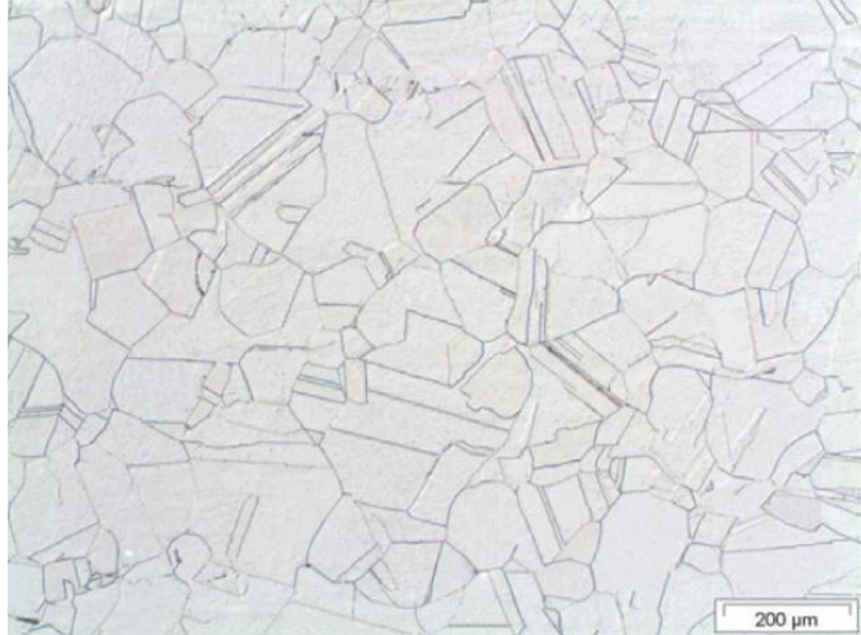
Figure 1. Microstructure of the solution-annealed AISI 304L stainless steel. Average grain size 40